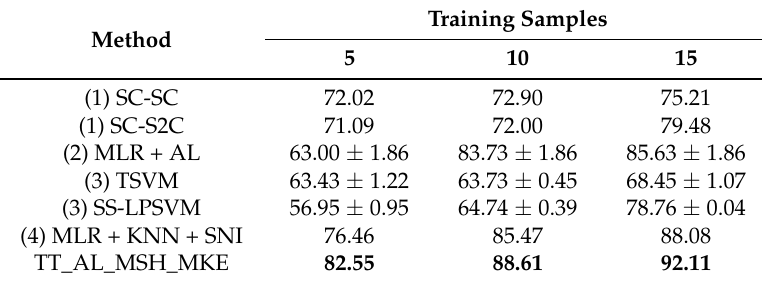
Table 9. Comparison of methods, denoted as TT_AL_MSH_MKE, with results reported in (1) [43], (2) [16], (3) [25] and (4) [27], for the ROSIS Pavia University dataset. The best OA results of each table are marked in bold